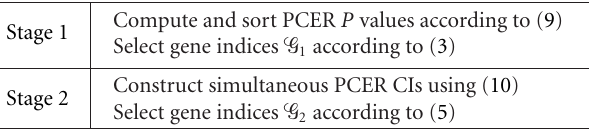
Table 2: Two stage FDR-CI algorithm for screening genes from the knockout versus wild-type